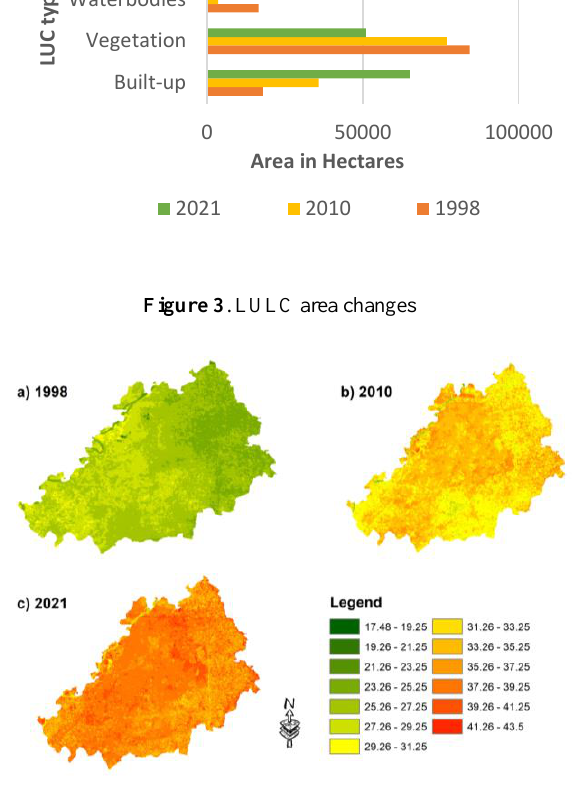
Figure 4 . LST distribution in